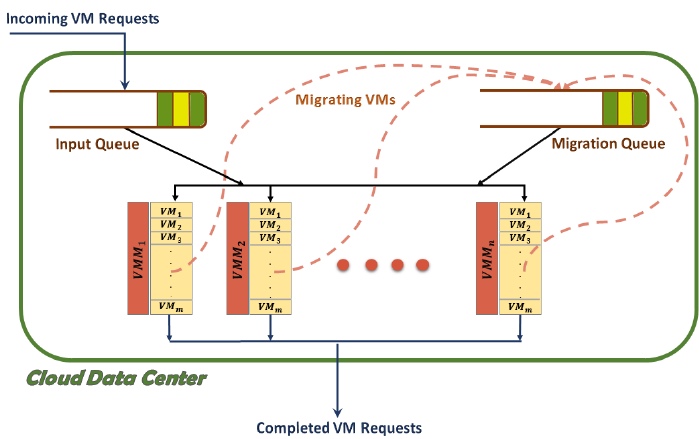
Figure 1. The structure of the Infrastructure-as-a-Service (IaaS) cloud system under study. Right after system startup, all PMs of the cloud data center are assumed to be switched-off and